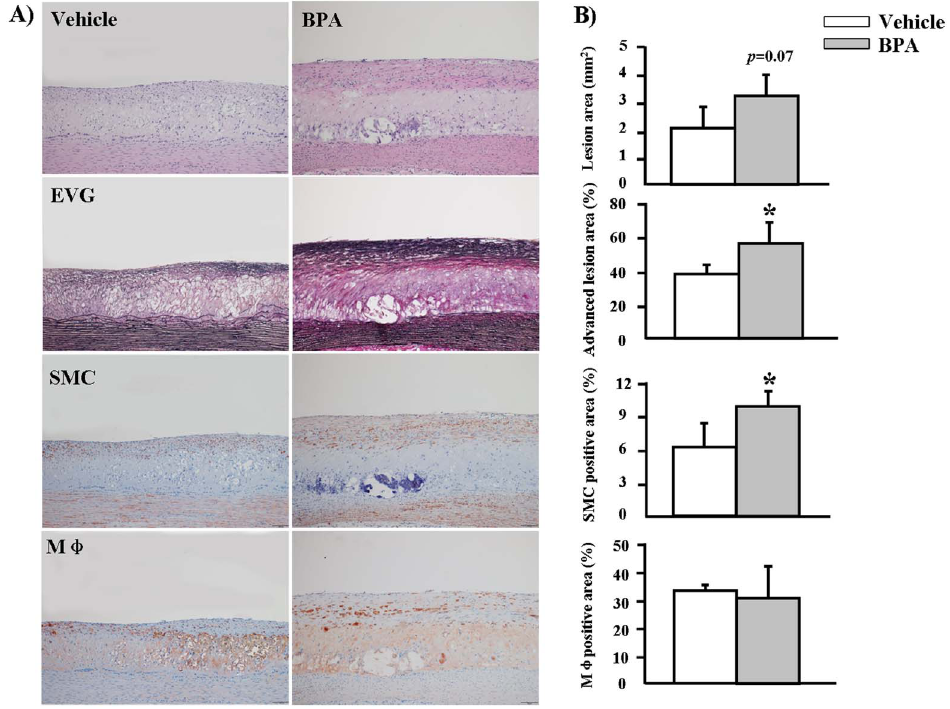
Figure 5. Microscopic analysis of atherosclerosis in the aortic arches of WHHL rabbits at 12 weeks. (A) Representative micrographs stained with H&E and EVG for intimal lesion analysis are shown in the top two panels. Representative micrographs stained with HHF35 and RAM11 mAbs for immunohistochemical analysis of SMCs and macrophages are shown in the lower two panels. (B) Intimal lesions, advanced lesions, SMCs and M Q -positive areas of the sections were quantified using an image analysis system as described in the Materials and Methods section. Data are expressed as the means 6 SD, n=6 for each group. * p , 0.05 vs. vehicle. Original magnification: 10 6 .